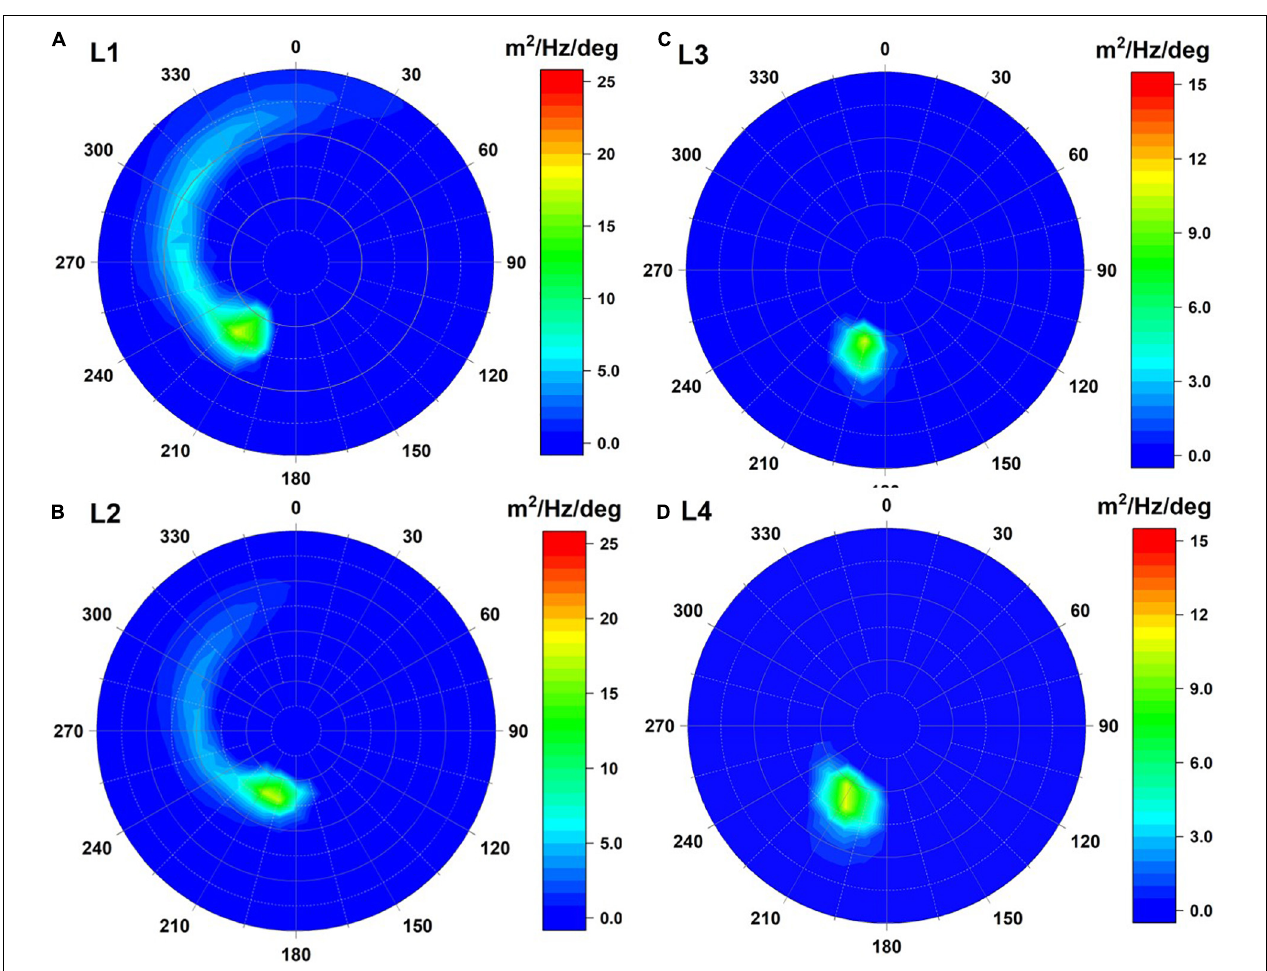
FIGURE 11 | Directional wave spectra generated by Super Typhoon Maria in 2018 at (A) L1, (B) L2, (C) L3, and (D) L4 four selected representative points at the time of the peak significant wave during single Super Typhoon Maria (2018).